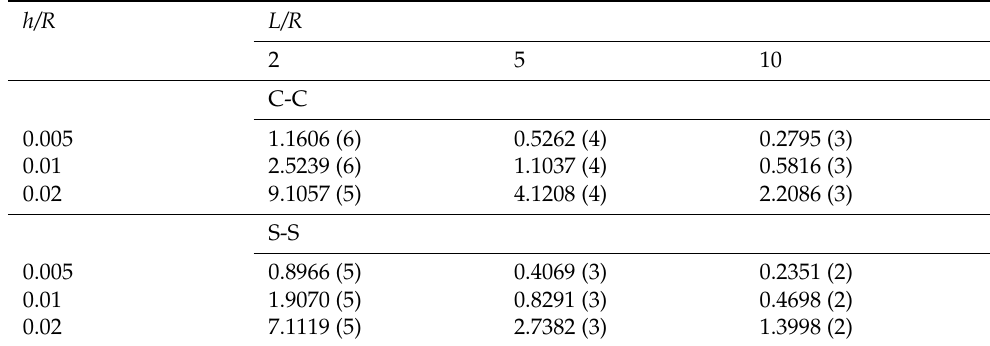
Table 2. Critical pressure of ring-stiffened porous GPLRC cylindrical shells for different boundary conditions, thickness–radius ratios and length–radius